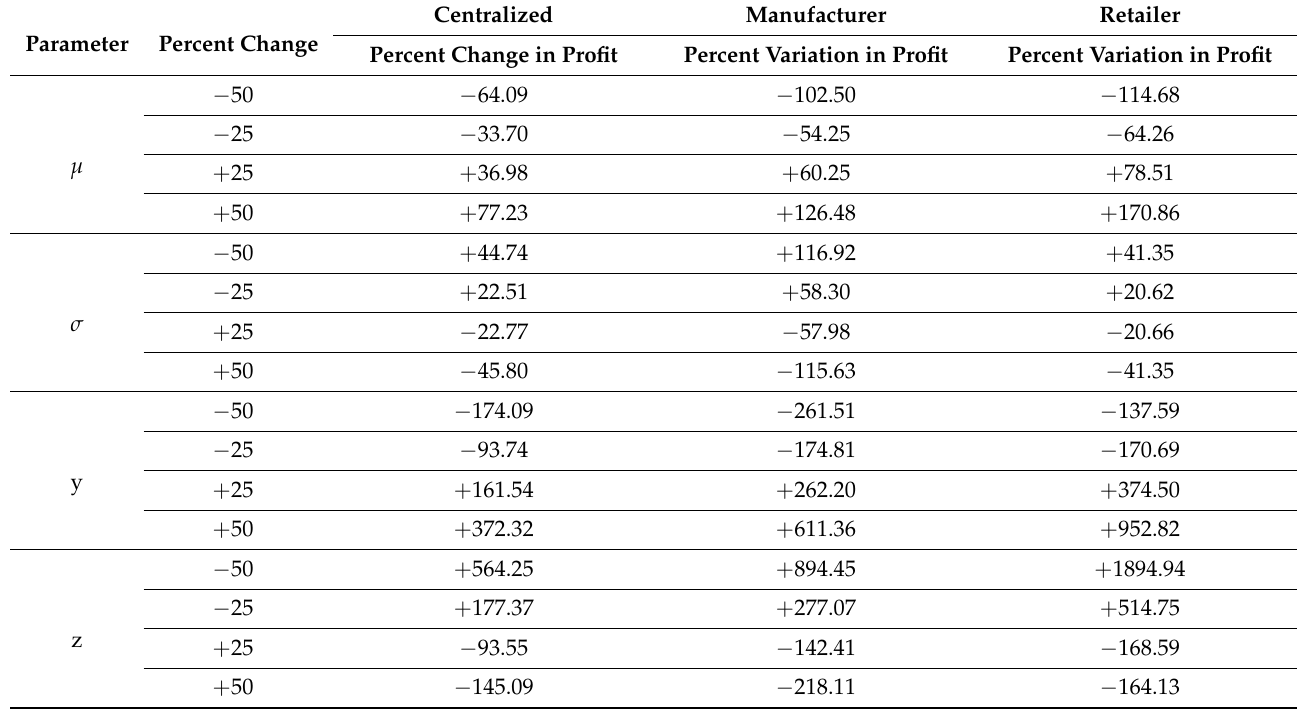
Table 5. Demand parameter sensitivity analysis.